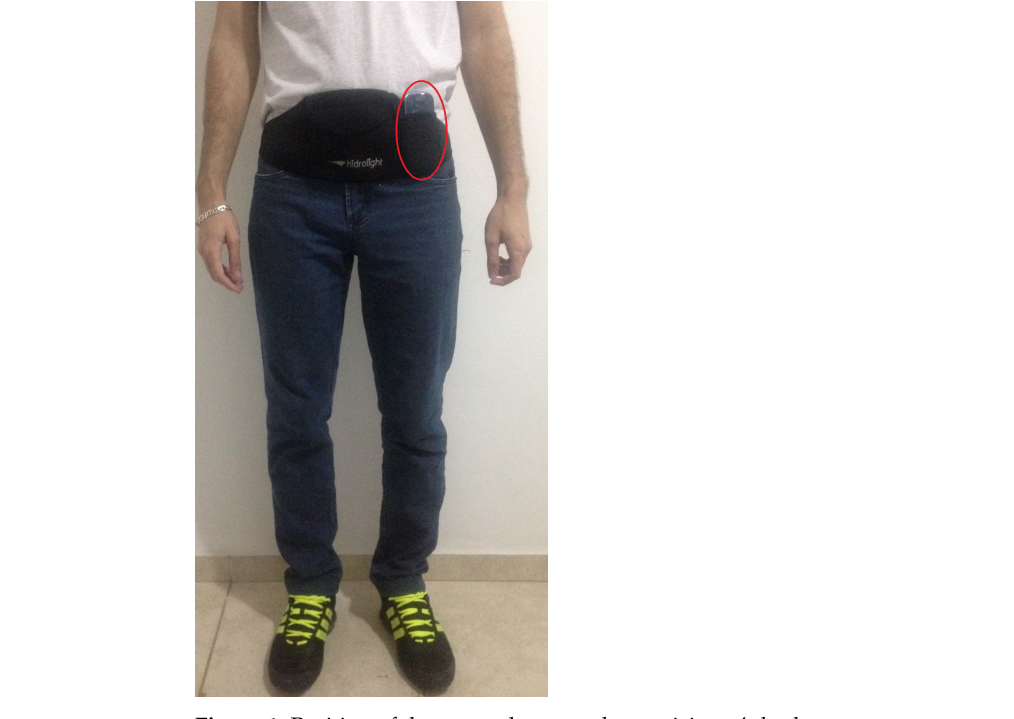
Figure 1. Position of the smartphone on the participant’s body.